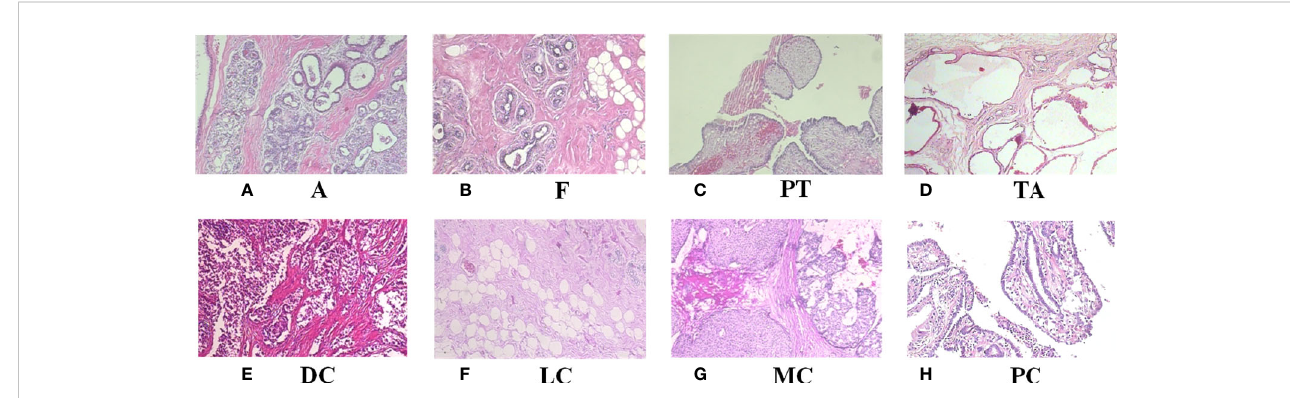
FIGURE 1 H&E-stained breast cancer histopathological images of 8 tumor types. (A) A, adenosis; (B) F, fi broadenoma; (C) PT, phyllodes tumor; (D) TA, tubular adenoma; (E) DC, ductal carcinoma; (F) LC, lobular carcinoma; (G) MC, mucinous carcinoma; (H) PC, papillary carcinoma.